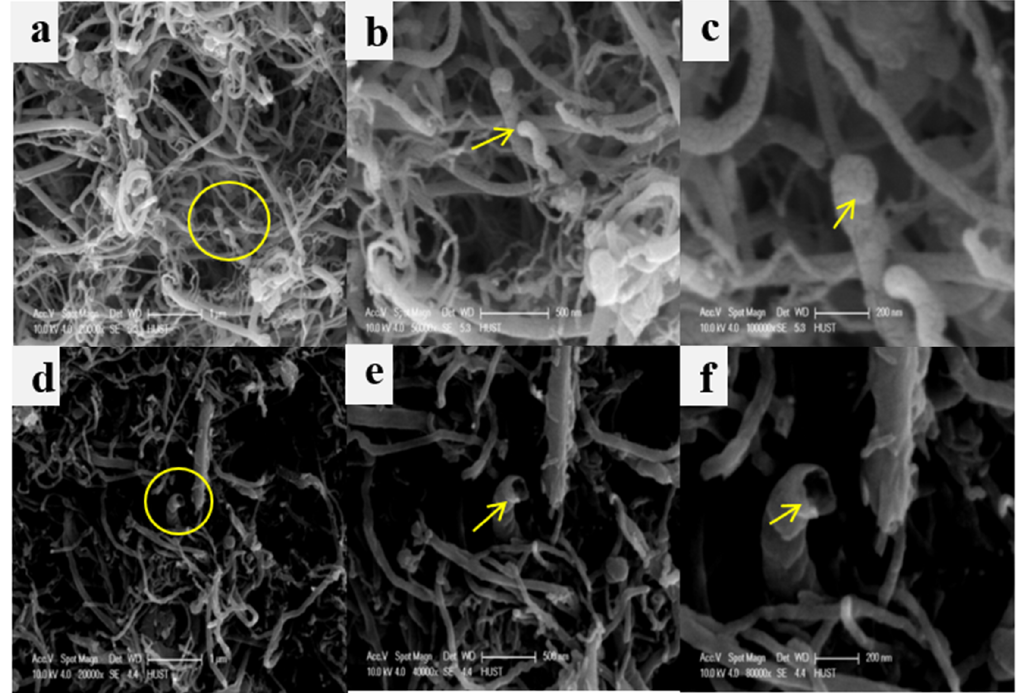
Figure 3. SEM images of MWCNTs before and after oxidation at different magnification scales: ( a – c ) crude MWCNTs; ( d – f ) oxidized MWCNTs.